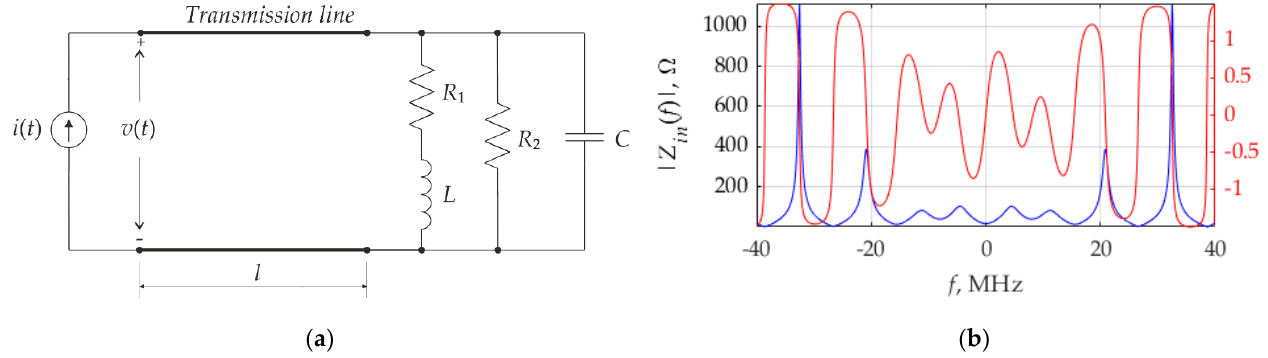
Figure 14. Transmission line loaded by the resonant circuit ( a ) and the frequency characteristic of its input impedance as impedance module and phase versus the excitation current frequency ( b ).